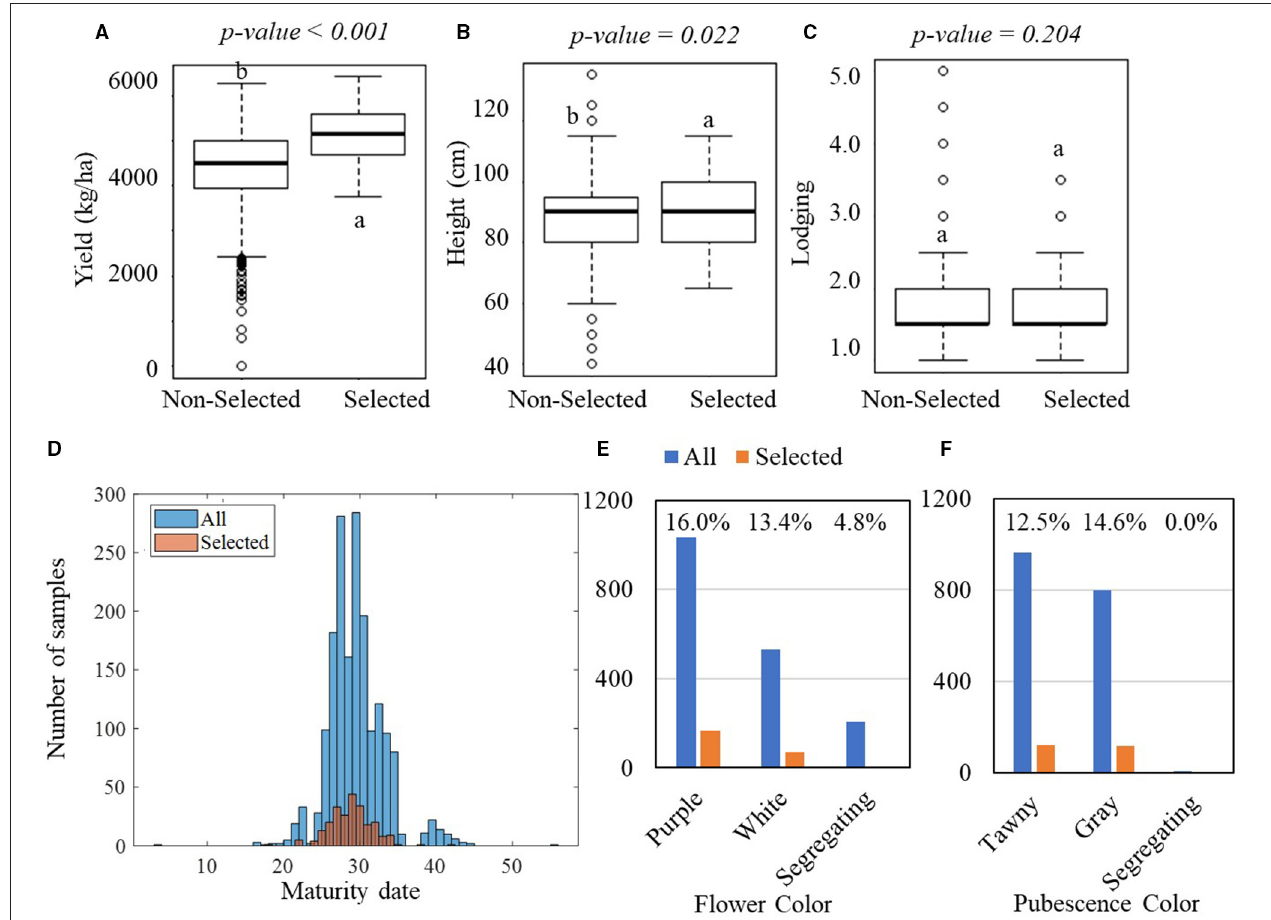
FIGURE 4 | Comparisons of manually measured agronomic traits between the selected and non-selected groups in the PYT. In the PYT, 238 breeding lines were selected, while 1,535 breeding lines were non-selected. (A–C) Boxplots of yield, plant height, and lodging for the selected and non-selected groups. The lower-case letters above bars indicate the significant difference among these means at the above significance levels ( p-values ). (D) Histogram of the maturity dates. (E,F) Bar plots of the flower and pubescence colors. The blue bars represent all plots, while the orange bars represent the selected